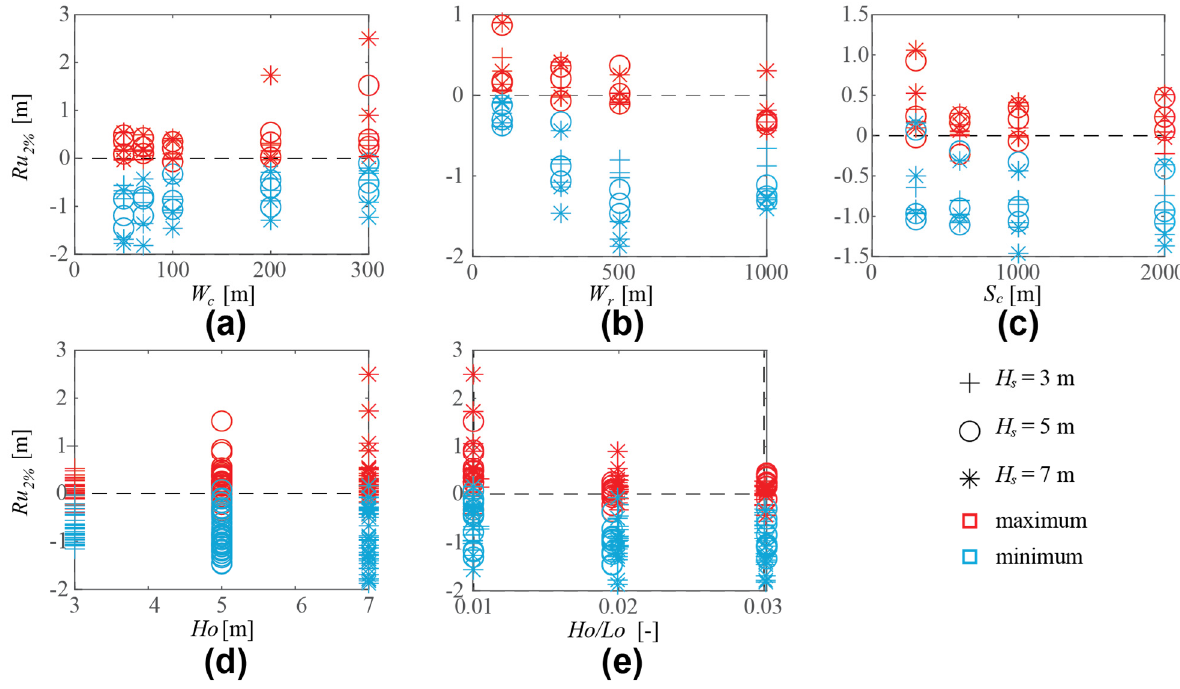
Figure 6. Runup, Ru 2% , for different reef and channel geomorphic parameters or oceanographic forcing parameters. ( a ) Channel width, W c . ( b ) Reef width, W r . ( c ) Channel spacing, S c . ( d ) Significant wave height, Ho . ( e ) Wave steepness, Ho/Lo . The marker shapes indicate the Ho and colors the minimum or maximum values for a simulation.